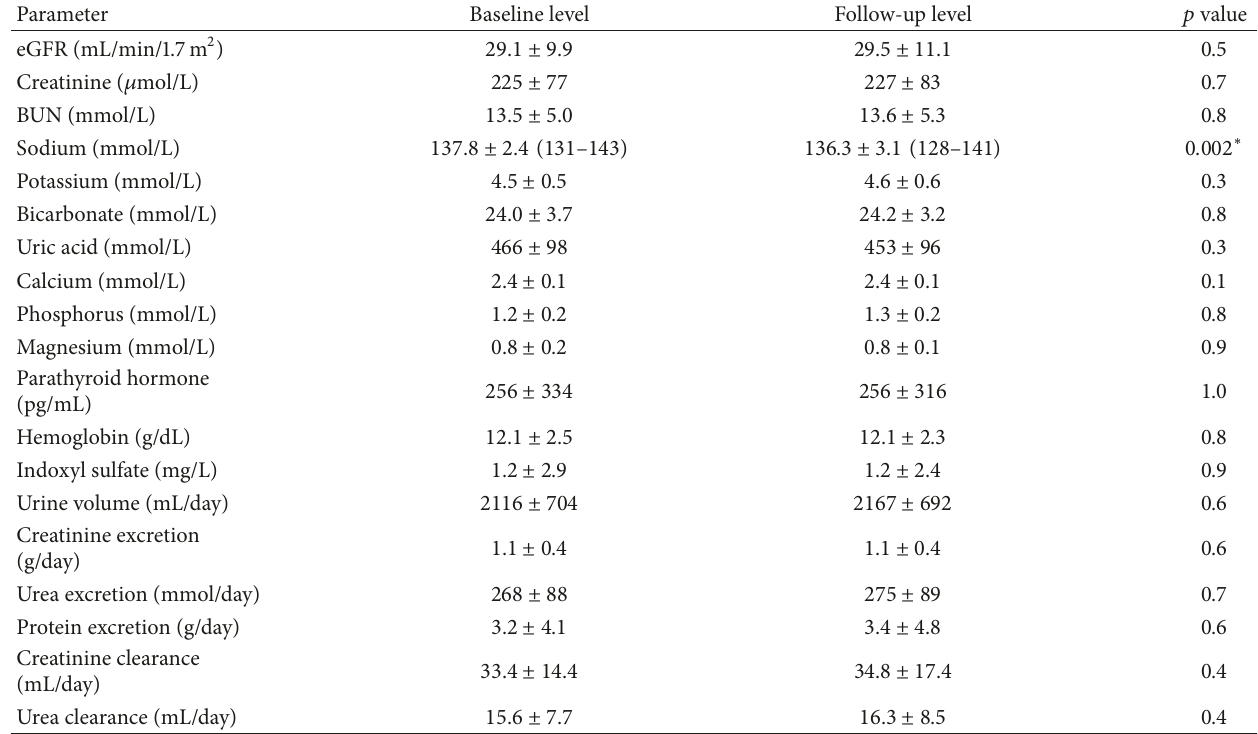
Table 2: Effect of Gum Arabic supplementation on renal parameters ( 𝑛 = 30 ).